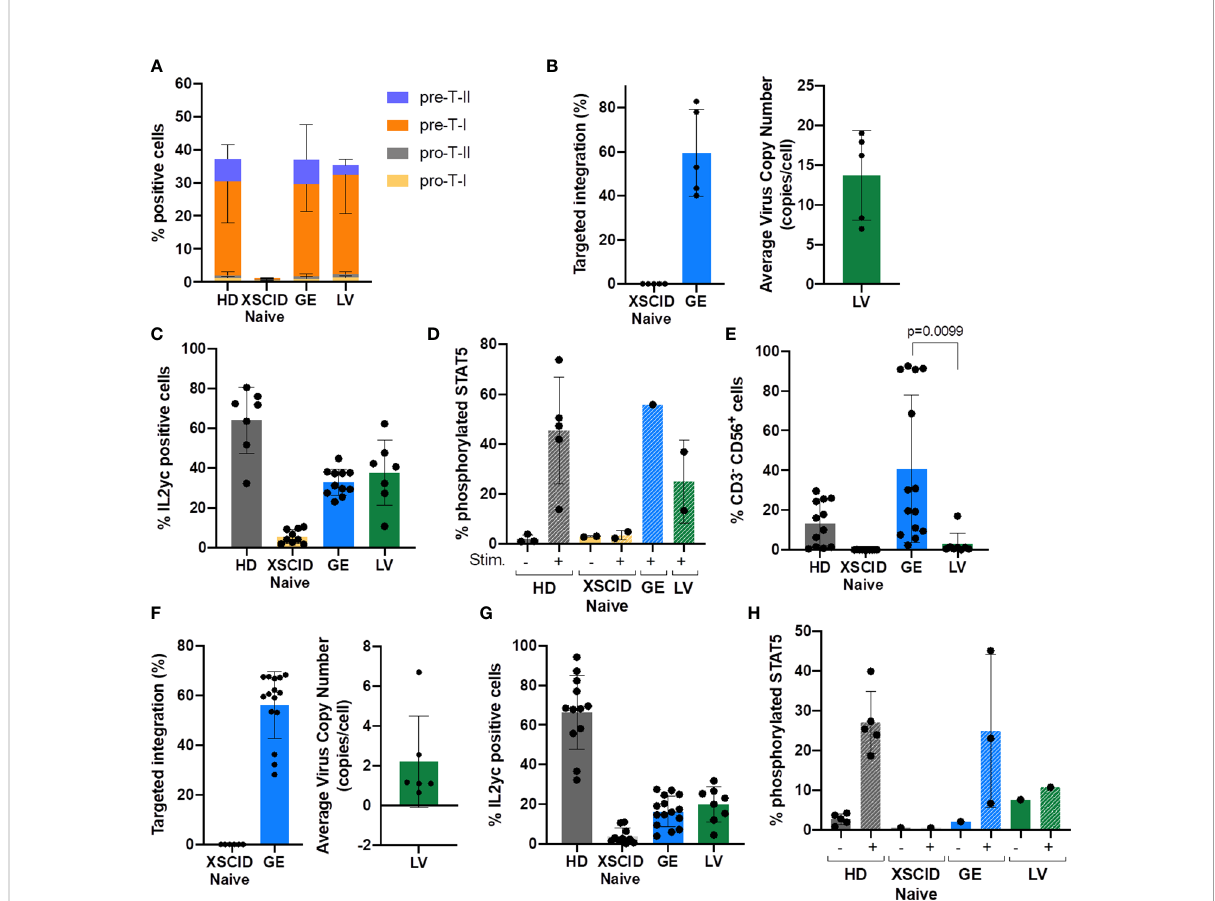
FIGURE 3 Evaluation of in vitro development of T and NK cells from GE- or LV-treated XSCID HSPCs and phenotypic/functional characterization. (A) Bar graph showing the relative proportion of CD34-derived T progenitors and precursor cells in each condition measured by fl ow cytometry at week 6 of in vitro differentiation (n = 9 independent experiments). (B) Percentage of TI and VCN quanti fi ed by ddPCR at week 6 of in vitro T cell differentiation (n = 5 independent experiments). (C) Percentage of T cells expressing IL2 g c measured by fl ow cytometry at week 6 of in vitro differentiation (n = 7 independent experiments). (D) Percentage of T cells with phosphorylated STAT5 after 15min of stimulation with IL2/IL7 (+) or left unstimulated (-) (n = 1-4 independent experiments). (E) Bar graph showing the percentage of CD34-derived NK cells (CD3 - CD56 + ) in each condition measured by fl ow cytometry at day 35 of in vitro NK differentiation (n = 12 independent experiments). (F) Percentage of TI and VCN quanti fi ed by ddPCR at day 35 of in vitro NK differentiation (n = 12 independent experiments). (G) Percentage of cells expressing IL2 g c measured by fl ow cytometry in NK cells at day 35 of in vitro differentiation (n = 12 independent experiments). (H) Percentage of NK cells with phosphorylated STAT5 after 15min of stimulation with IL2/IL15 (+) or left unstimulated (-) (n = 3-5 independent